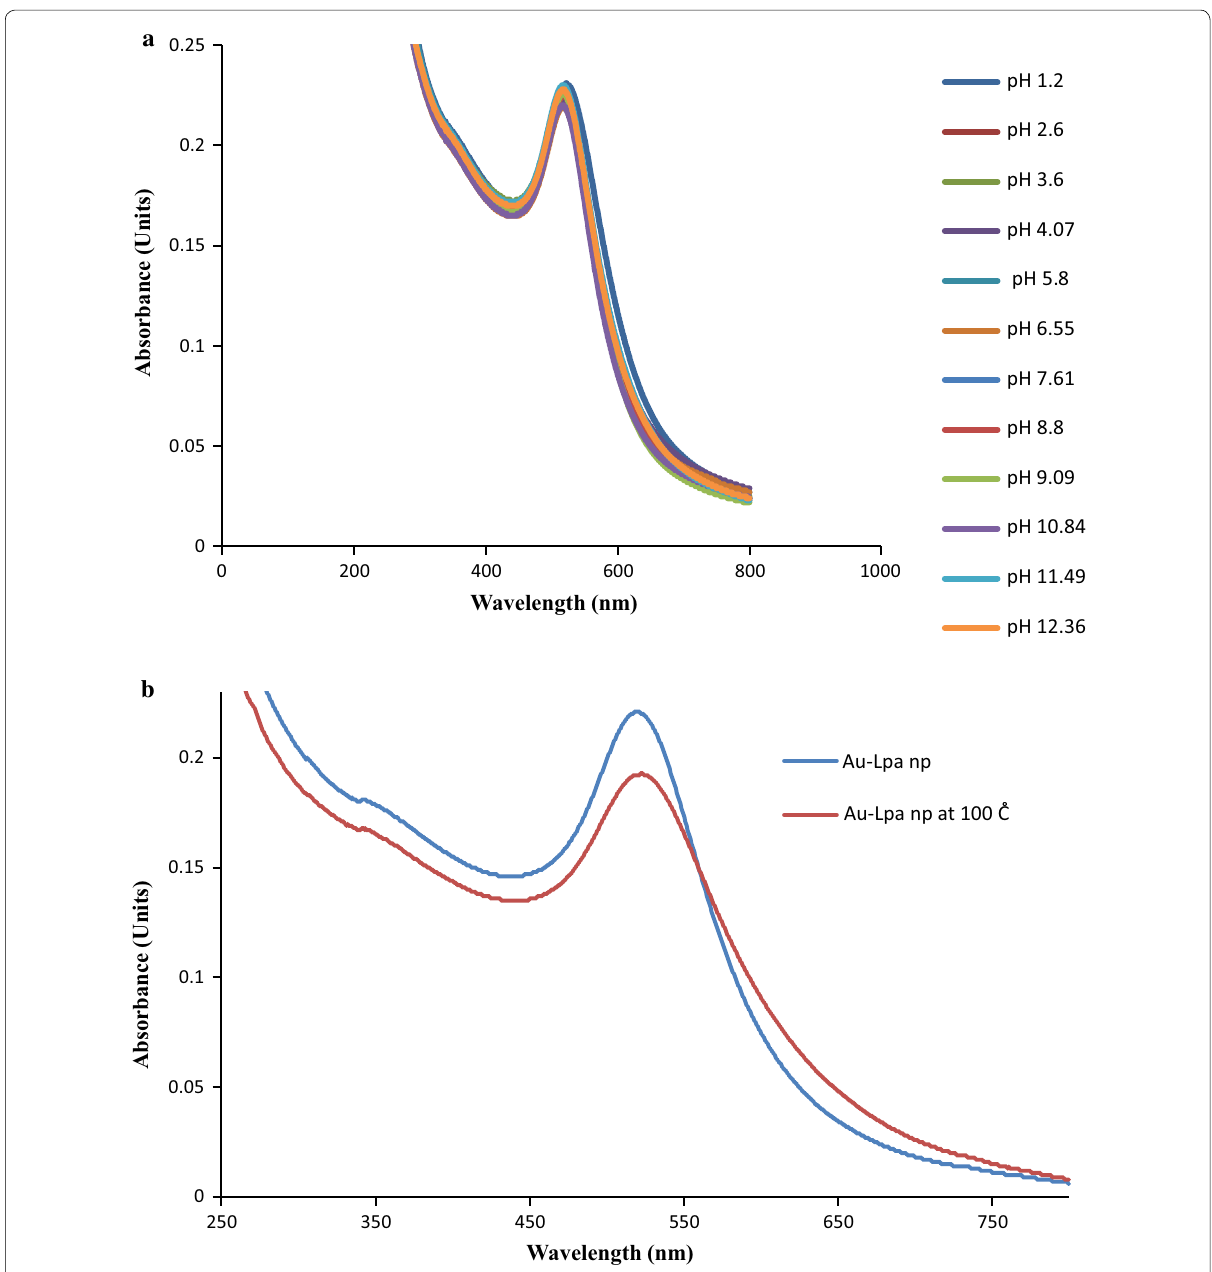
Fig. 4 a UV–Visible spectra showing no effect of pH on Au-LPa nanomaterials stability. b UV–visible spectrum for temperature tolerance of